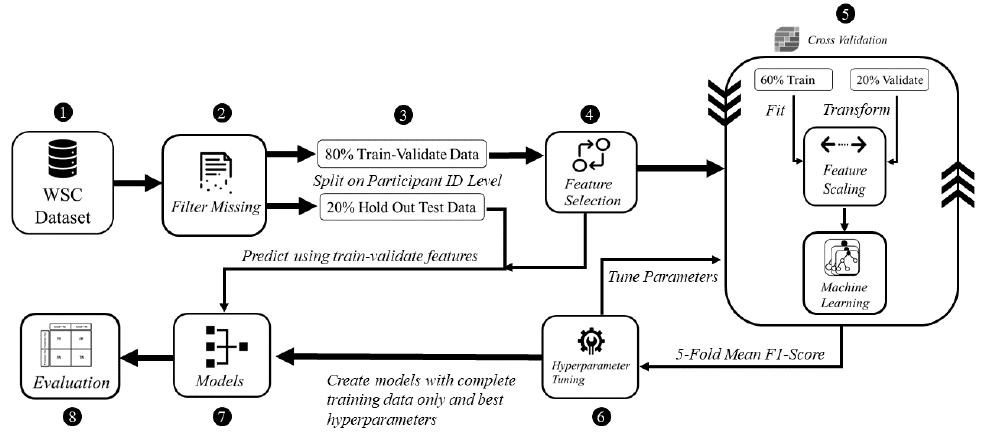
Figure 1. High level view of the proposed